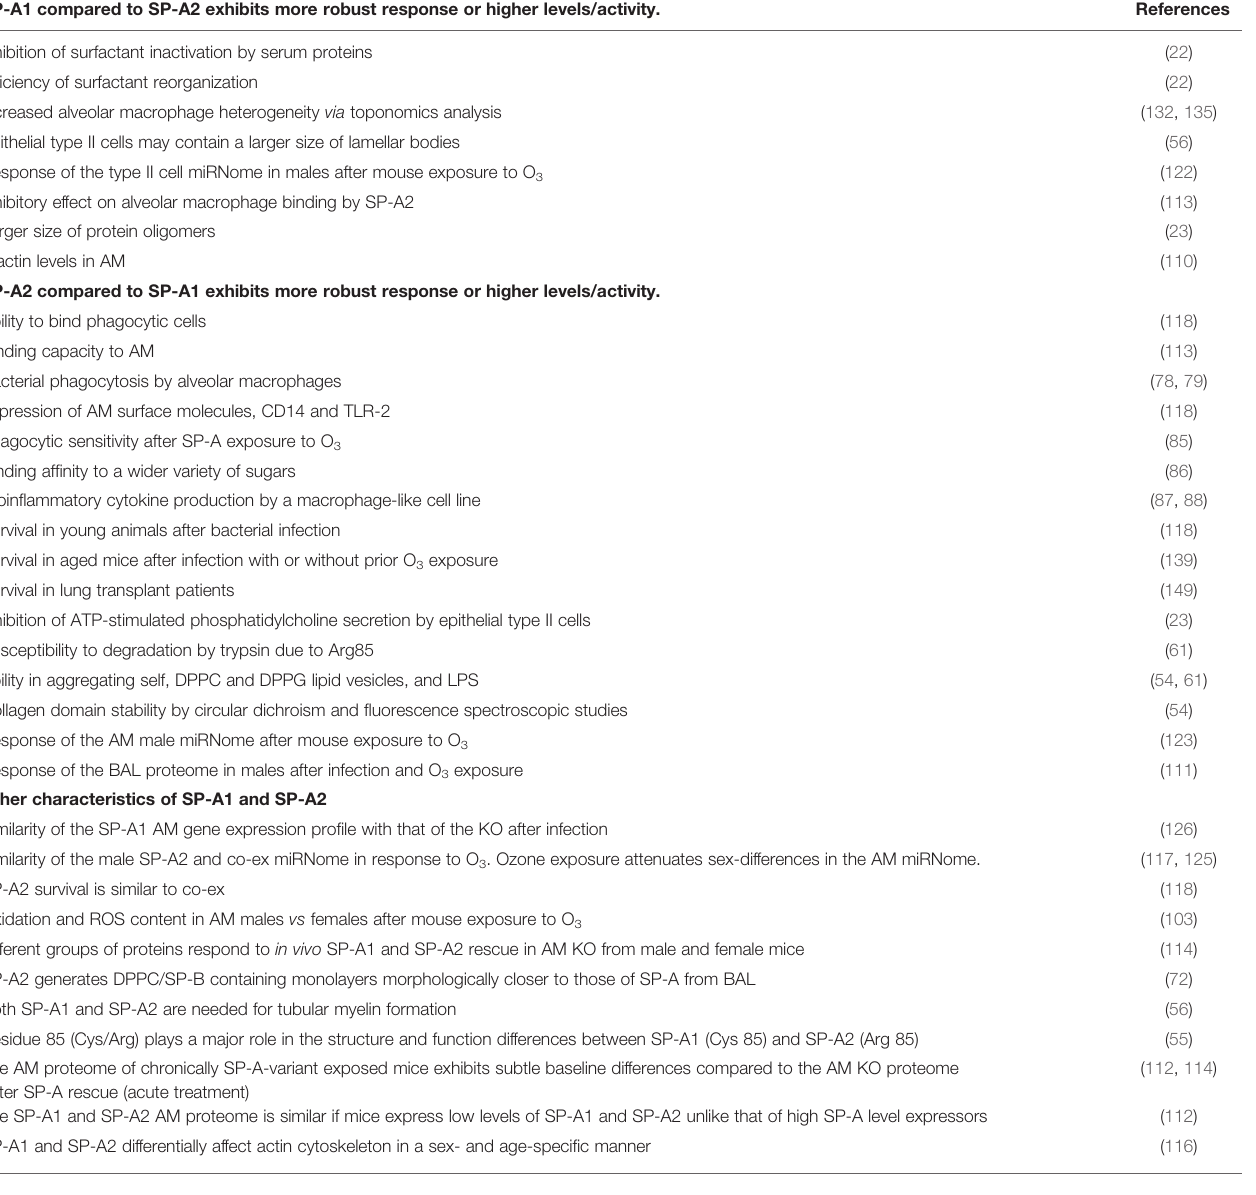
TABLE 4 | Functional differences between SP-A1 and